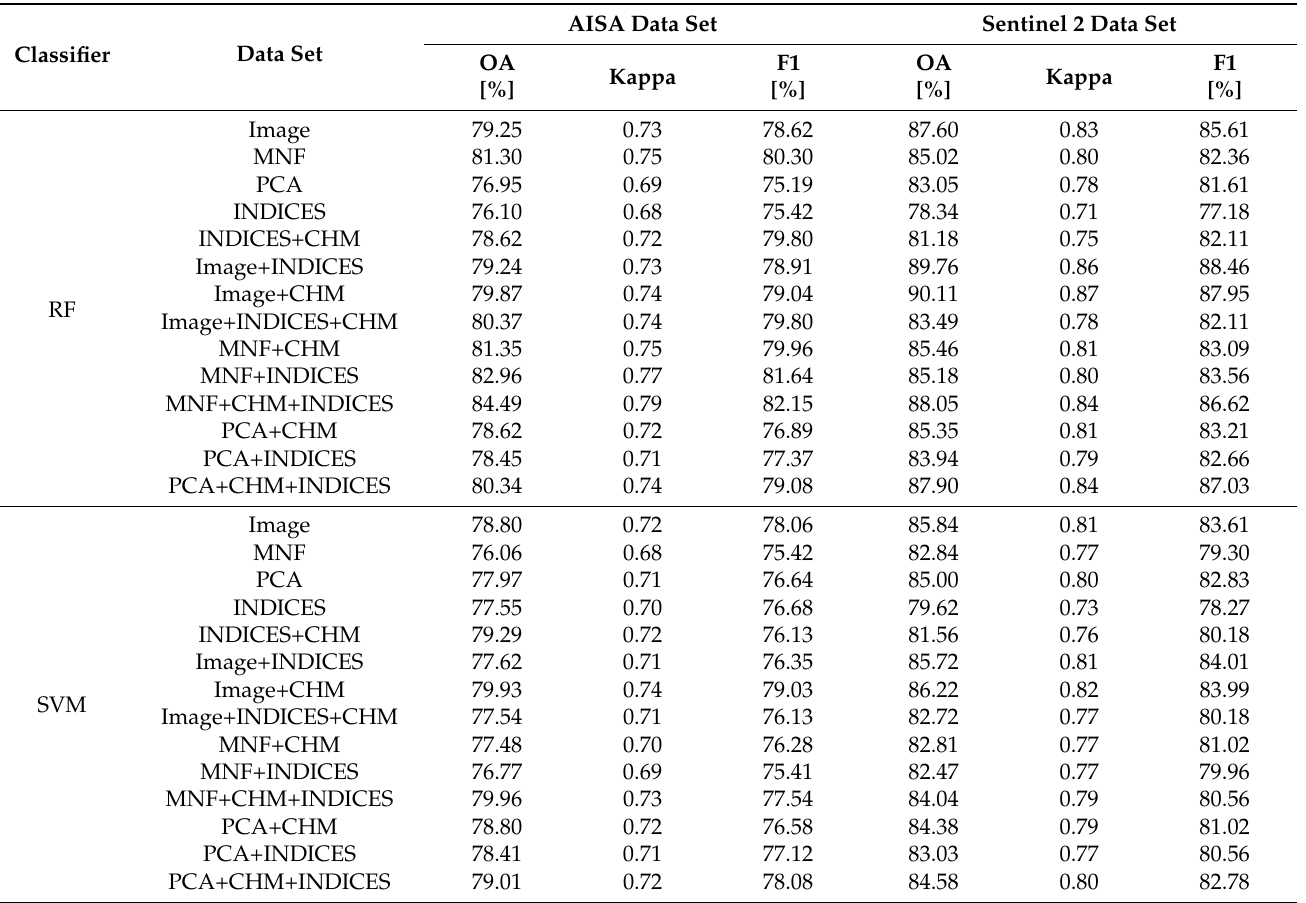
Table 5. Average values of: Overall Accuracy (OA), Kappa coefficient and F1-score for AISA and Sentinel-2 data